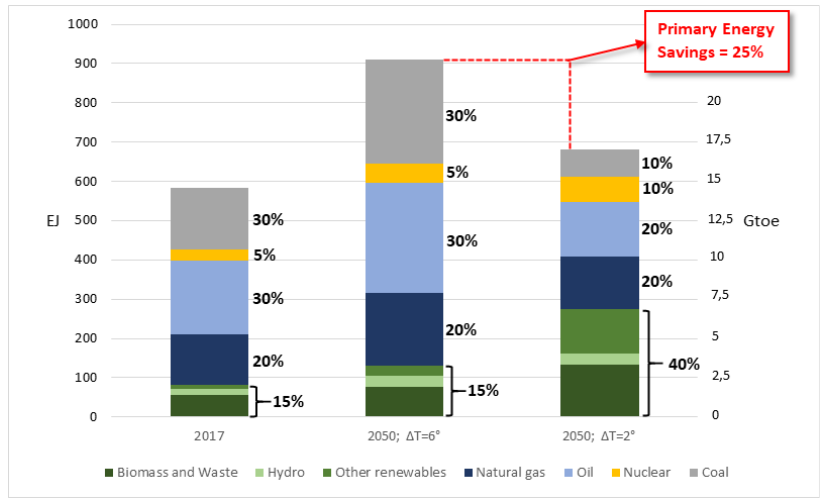
Figure 2. World total primary energy supply in 2017 detailed by fuel [7,8].